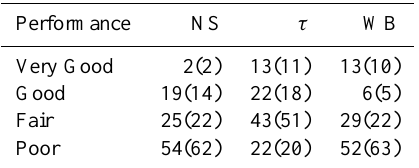
Table 4. Modelled runoff qualified by percentage of catchments in each performance category for the LTSA dataset and, in parenthesis, the TSA